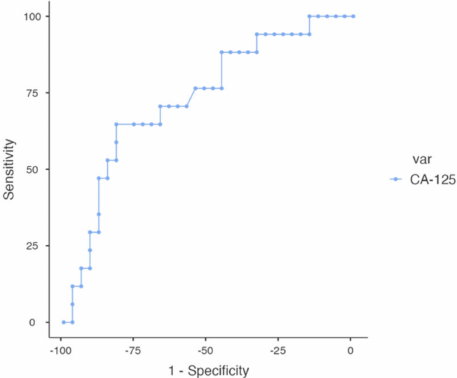
Figure 3. ROC curve of serum CA-125 and severe